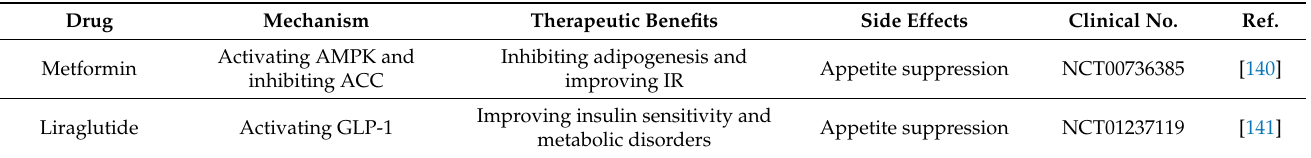
Table 1. Mechanisms and primary outcomes of potential drugs for treating